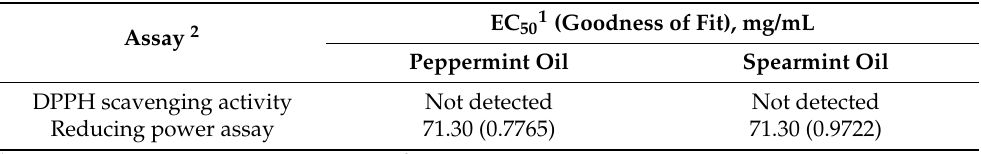
Table 1. The half-maximal effective concentration of peppermint and spearmint oils measured by chemical-based antioxidant activity assays.